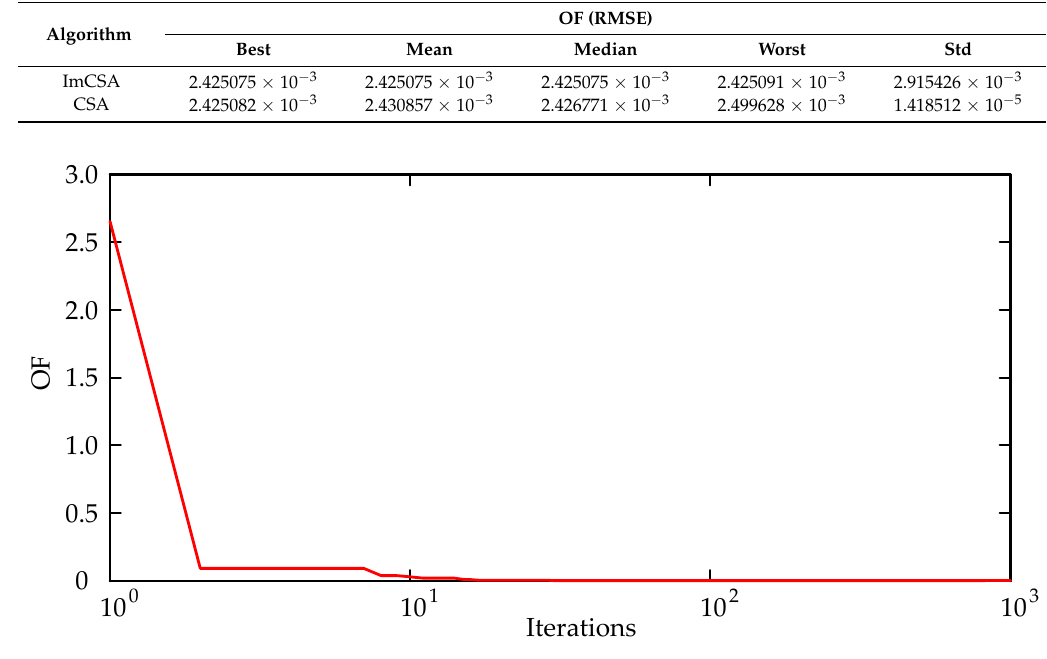
Table 8. Comparison among various parameter estimation algorithms for the PMM of Photowatt- PWP201 module.